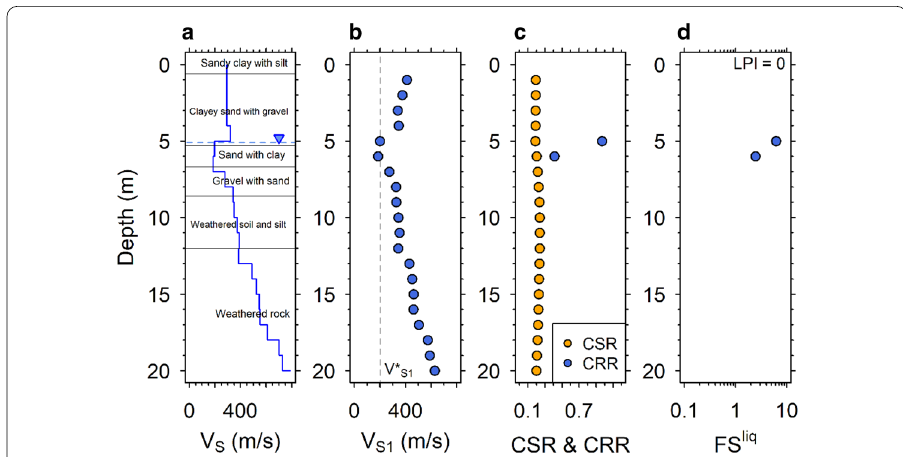
Fig. 3 Profiles of a raw V S measured from the downhole test; b corrected V S by an overburden stress ( V S 1 ); c cyclic stress ratio and cyclic resistance ratio (CSR and CRR, respectively); and d factor of safety against liquefaction (FS liq ) at Site 1, where sand boils were not observed (non-liquefied site). The LPI is shown at the top right of ( d ). The sand with clay at a depth of 6 m has a fines content of 16.2%